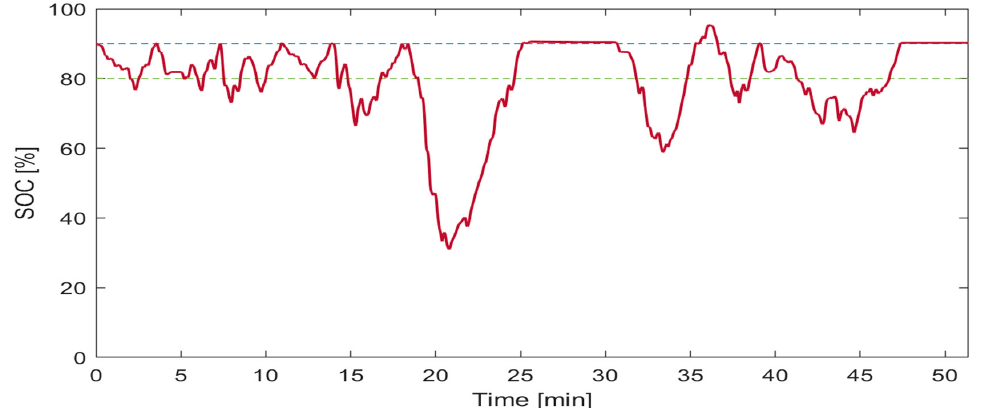
Figure 12. FESS bench state of charge.